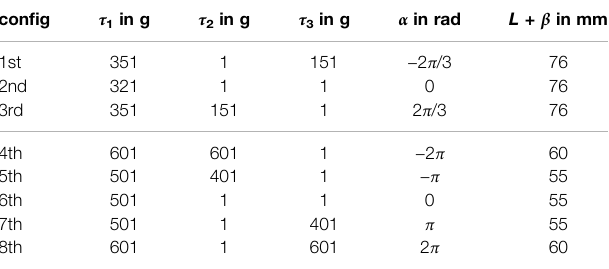
TABLE 3 | Con fi gurations for position redundancy assessment. The tendon tensions are indicated by the mass of the precision weights. con fi g τ 1 in